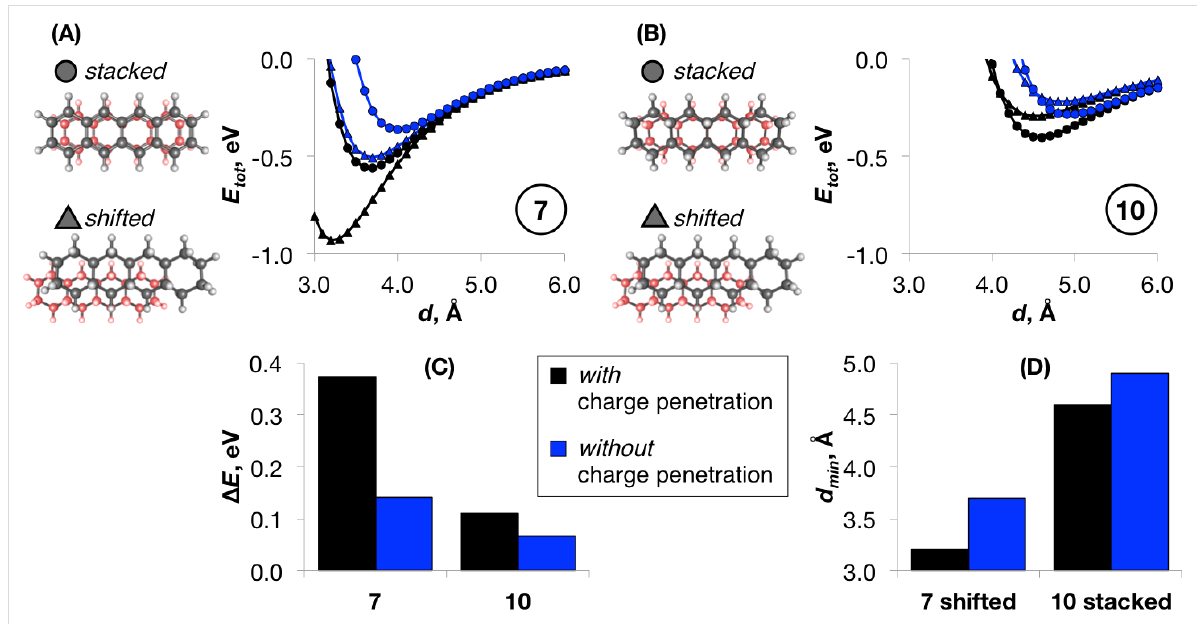
Figure 5: Structures and SAPT0/jun-cc-pVDZ interaction energy profiles with and without the charge penetration contribution vs varying inter- monomer distance d for stacked and shifted dimers of tetracene ( 7 , A) and perhydrotetracene ( 10 , B). (C) The absolute SAPT0/jun-cc-pVDZ ener- getic difference between the energy minima on the shifted and stacked dimer profiles with and without the E Cpen . (D) The interplanar separation, cor- responding to the minimum energy dimer for 7 and 10 with and without the E Cpen